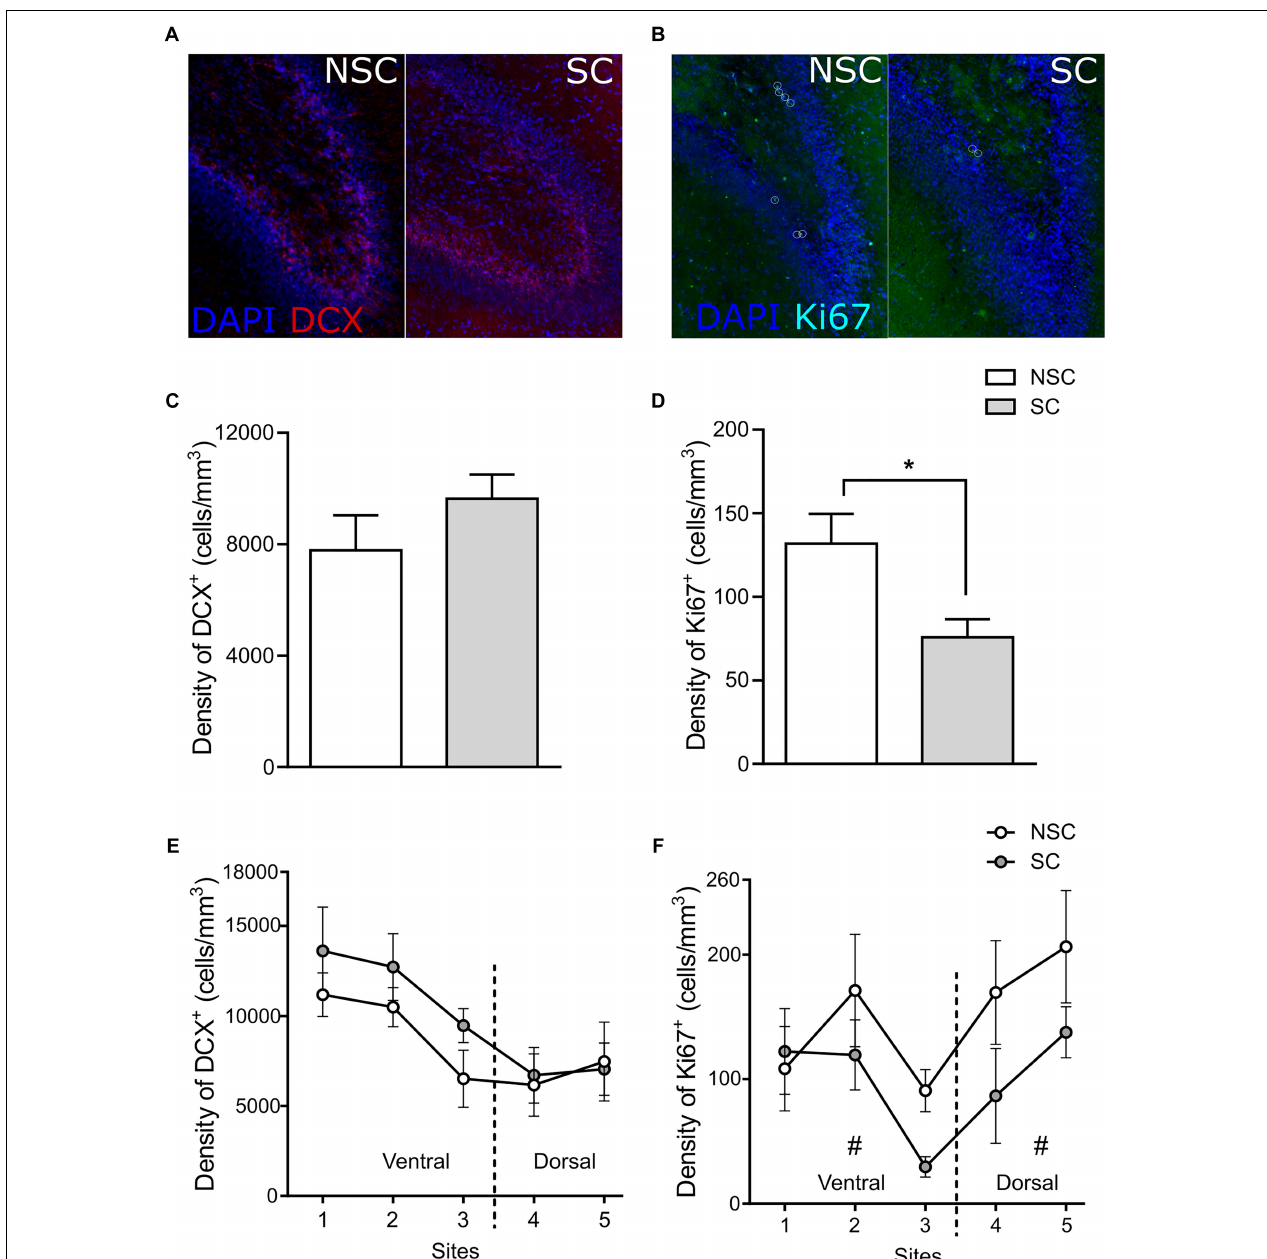
FIGURE 5 | Hippocampal structural plasticity. Distribution of DCX + (doublecortin) (A) and Ki67 + cells (B) in the hippocampus and in the GCL (granular cell layer) of a stressed (SC) and a non-stressed (NSC) animal (DCX/DAPI and Ki67/DAPI markers, respectively). On the totality of the five sections there was no difference in the GCL volume and in the density of DCX + cells in the GCL (C) . SC animals had a significantly lower density of Ki67 + cells [ F (1,12) = 6.082, p = 0.030] (D) . The density of DCX + cells did not differ in any of the observed sites (E) , however, the number of cells was significantly higher in the ventral zone of SC compared to NSC animals [ F (1,12) = 6.535, p = 0.025]. The density of Ki67 + cells tended to be lower in the ventral and in the dorsal parts of NSC compared to SC animals [ F (1,12) = 3.604, p = 0.082, and F (1,12) = 3.678, p = 0.079, respectively] (F) . N = 7–8/group, mean ± SEM, one-way ANOVA, # p < 0.1, ∗ p <